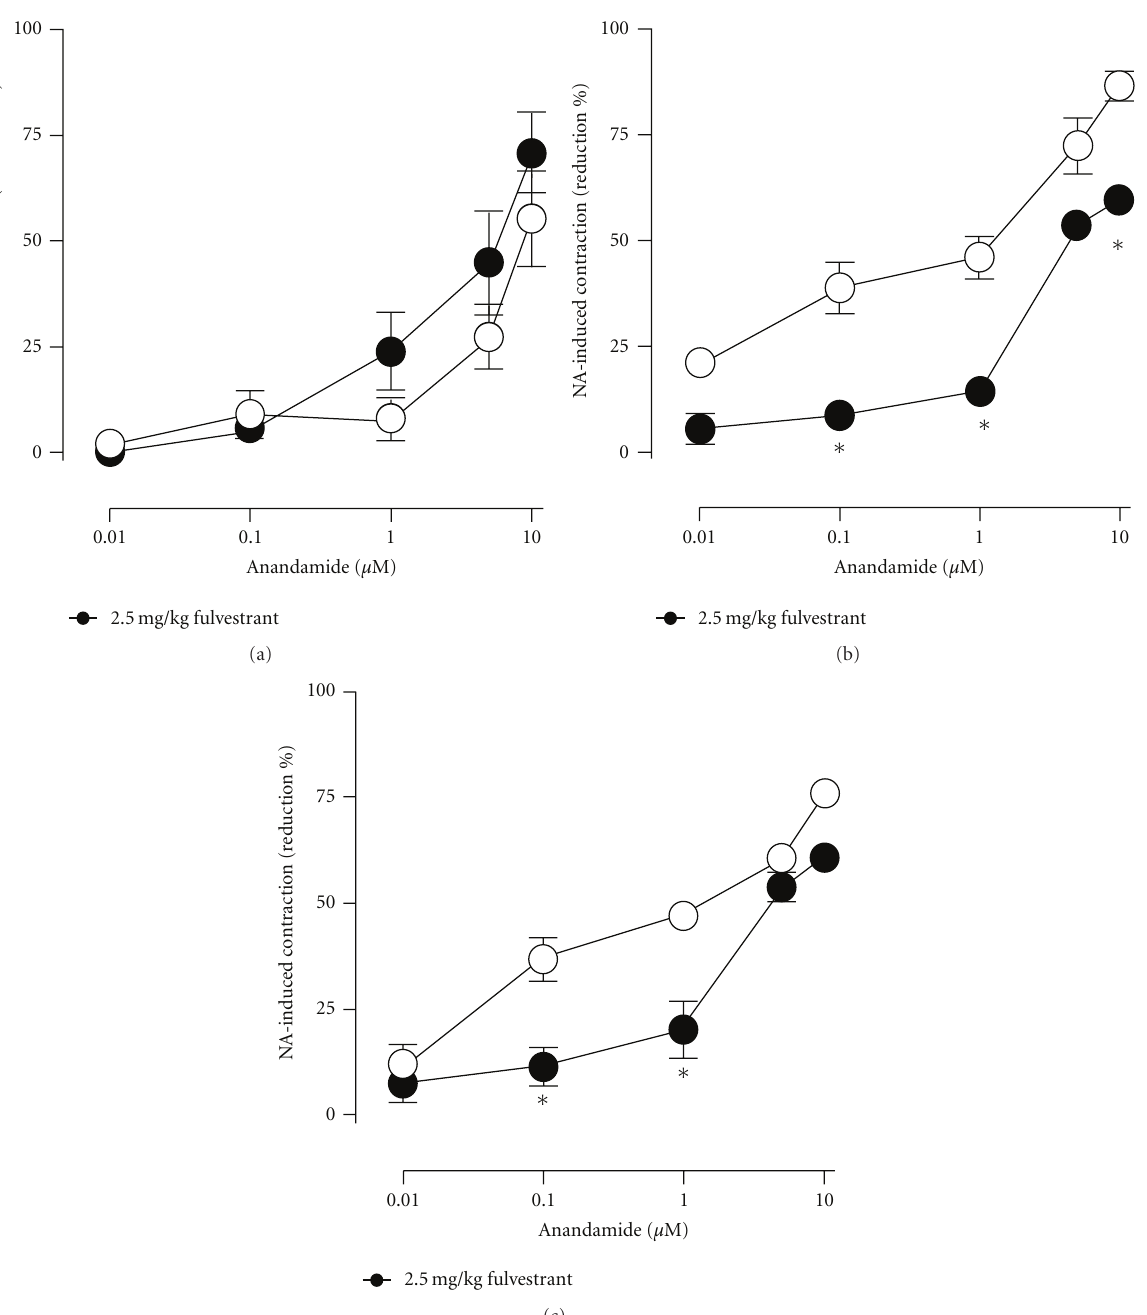
Figure 5: E ff ects of 3-day s.c. administration of 2.5 mg/kg of fulvestrant on the anandamide-induced reductions of contractile responses to NA in untreated (a), genistein-treated (10mg/kg; (b)), or daidzein-treated (20mg/kg; (c)) OVX female rats. Fulvestrant (filled circles) or its vehicle (open circles) were concomitantly administered with the corresponding phytoestrogen treatment. ∗ P < 0 . 05 when phytoestrogen- treated were compared against phytoestrogen plus fulvestrant-treated OVX female